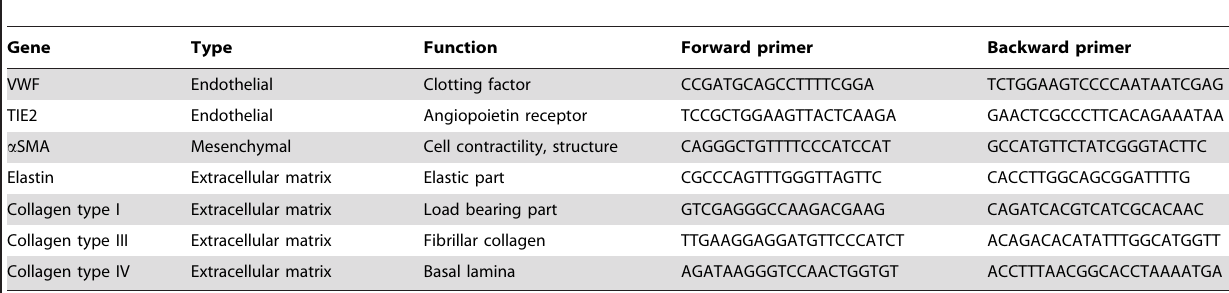
Table 1. EndoMT markers and ECM genes and corresponding primer sequences used for